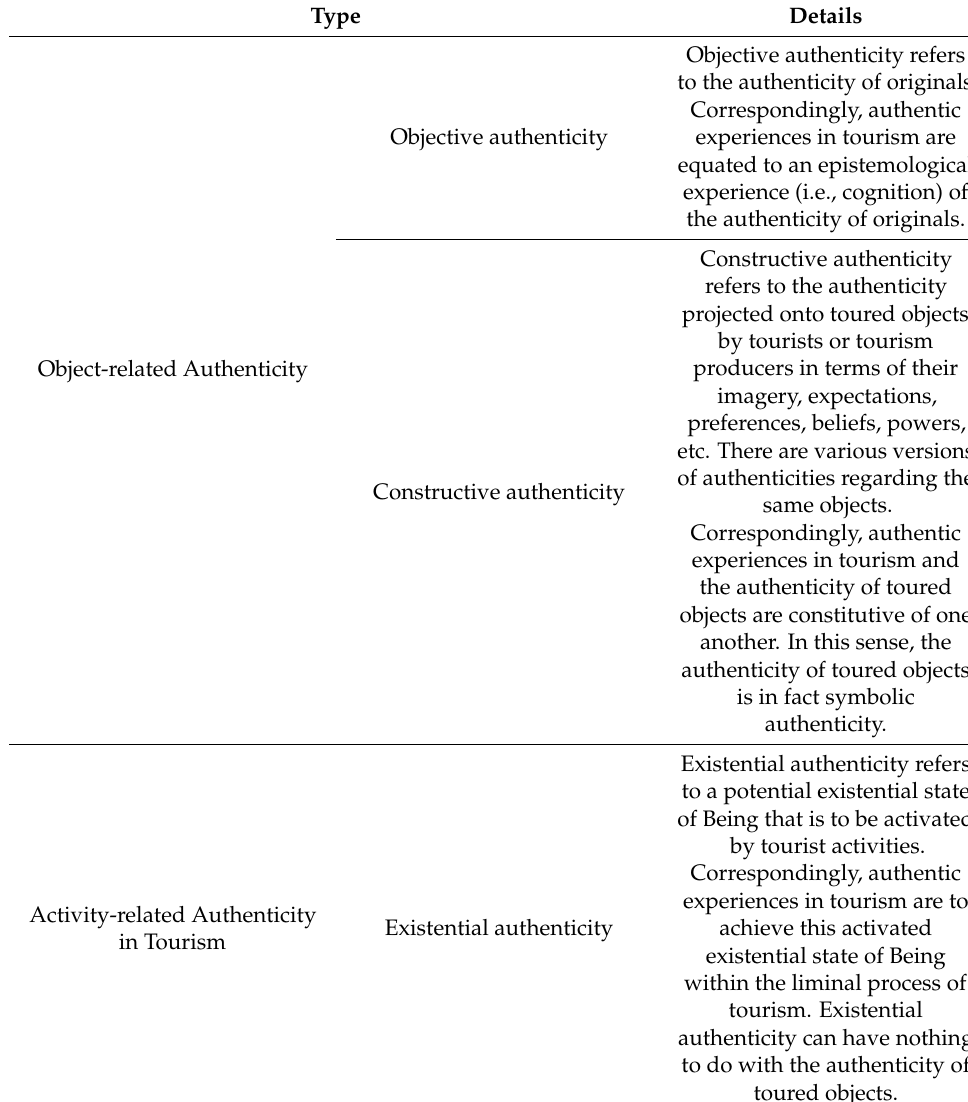
Table A1. Three Types of Authenticities in Tourist Experiences by Wang